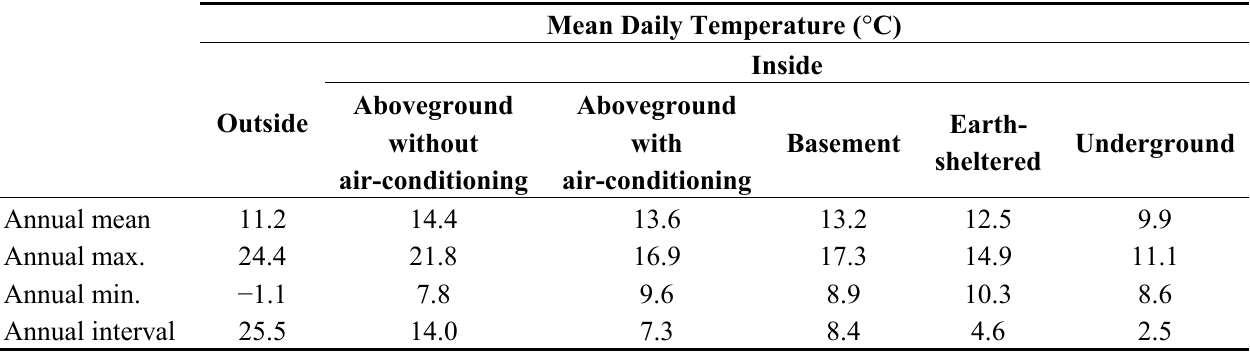
Table 1. Representative temperature values inside and outside the constructions. Average year over the 2006–2009 period, calculated from daily mean